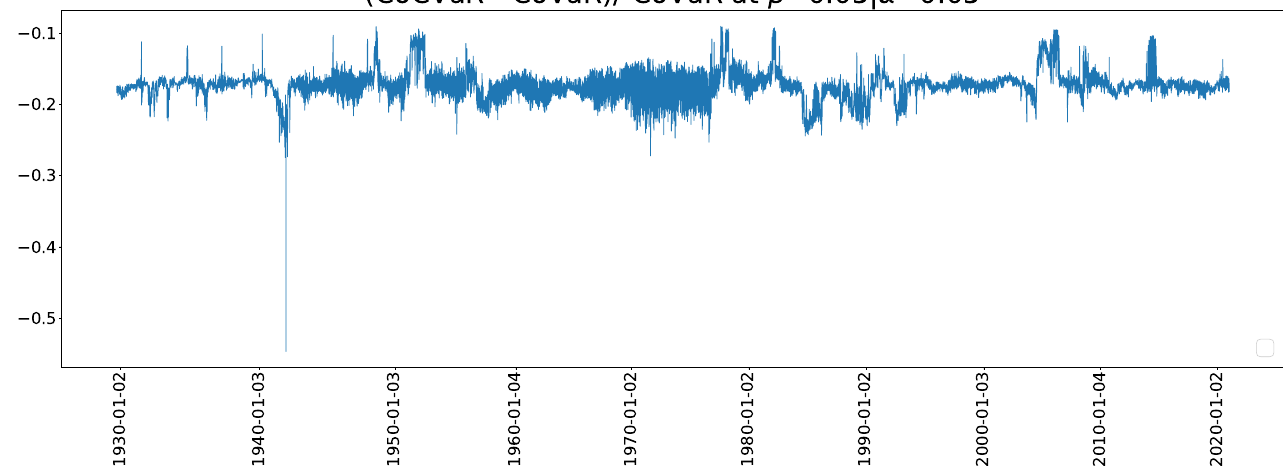
Figure 16. A relative difference between CoCVaR and CoVaR for α = β =